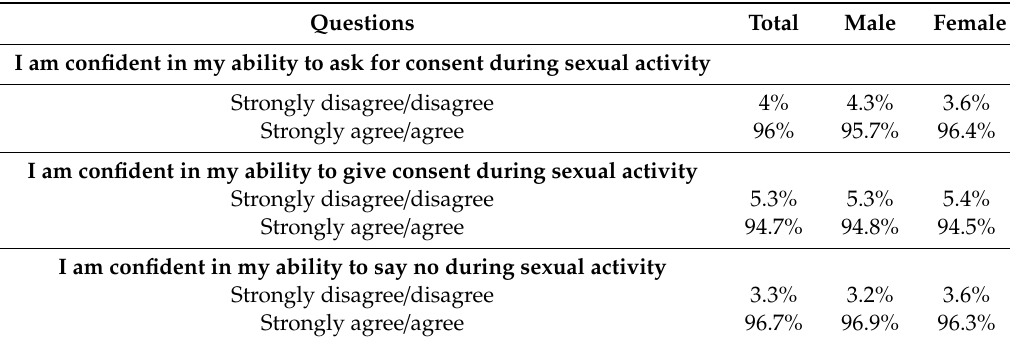
Table 3. Results from quantitative survey on self-e ffi cacy of